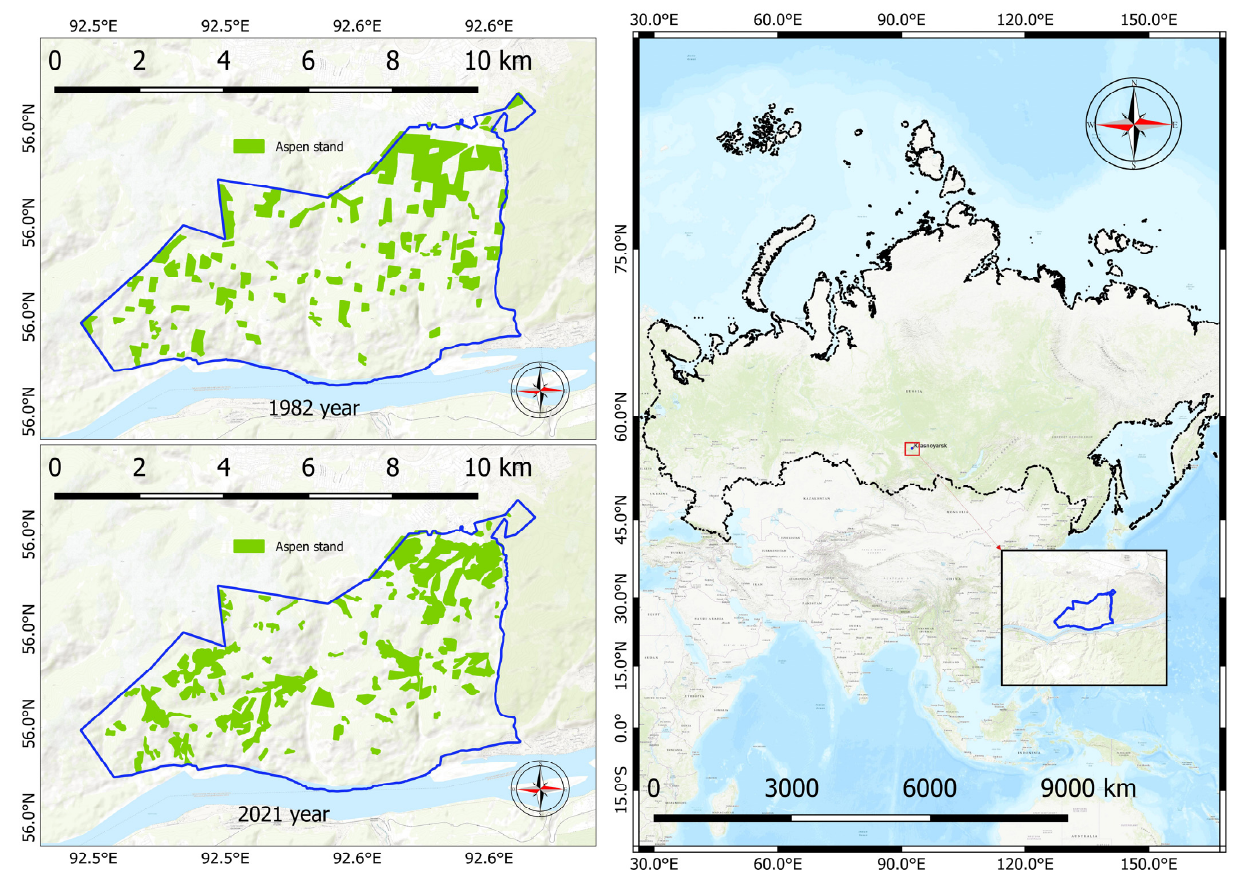
Figure 1. Study area outline map (right side) and dynamics of the area covered by the aspen forests according to the data of